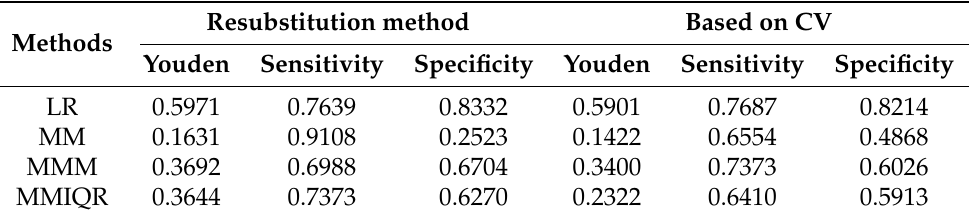
Table 6. Maximum Youden index for each method. SGA